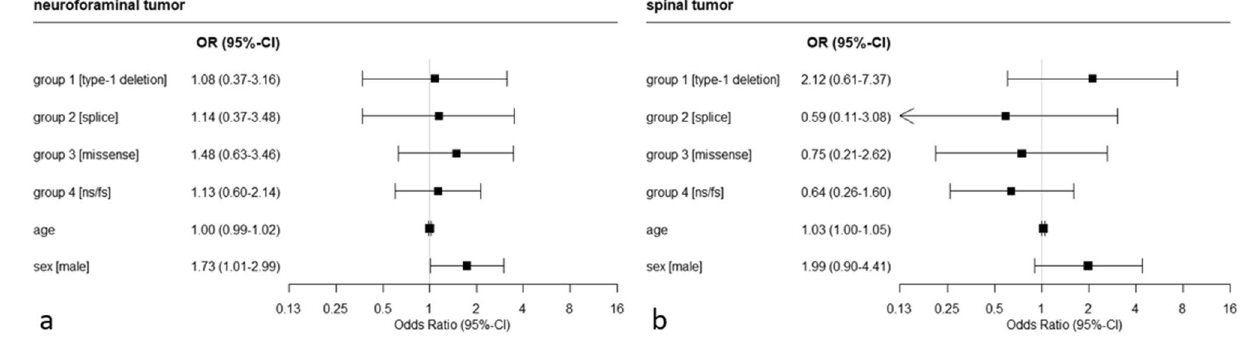
Figure 3. Results of logistic regression analysis on the association of neuroforaminal ( a ) and spinal ( b ) tumors with type of mutation of the NF1 gene, age and sex.